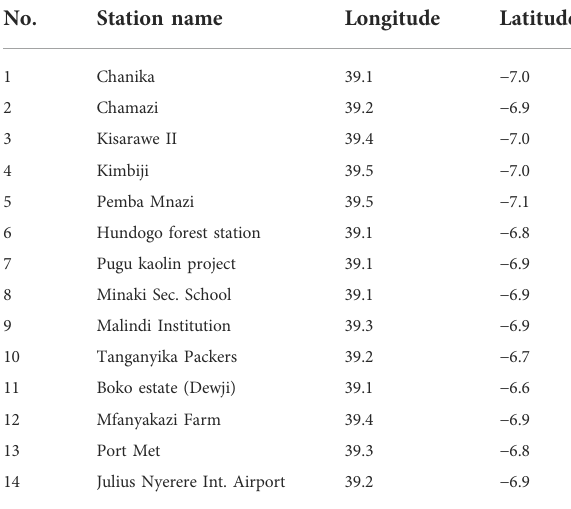
TABLE 1 Stations used in the